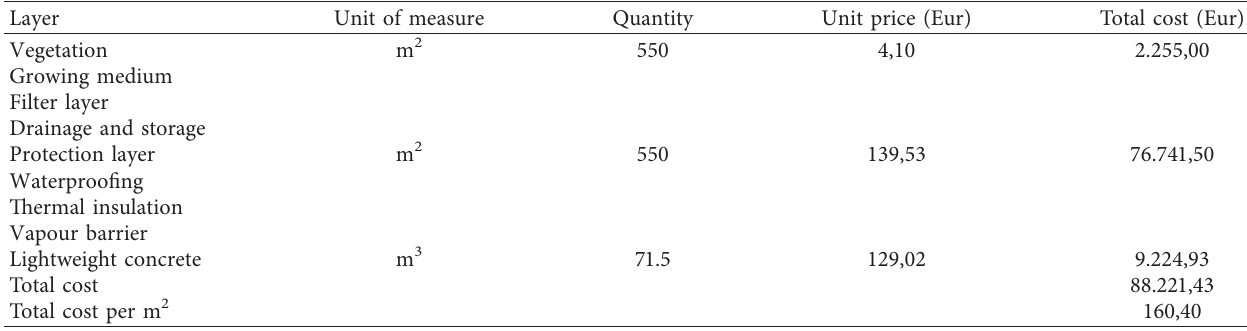
Table 7: Intensive green roof construction costs (the table is structured by authors upon data collected from cost estimate for the building under construction).